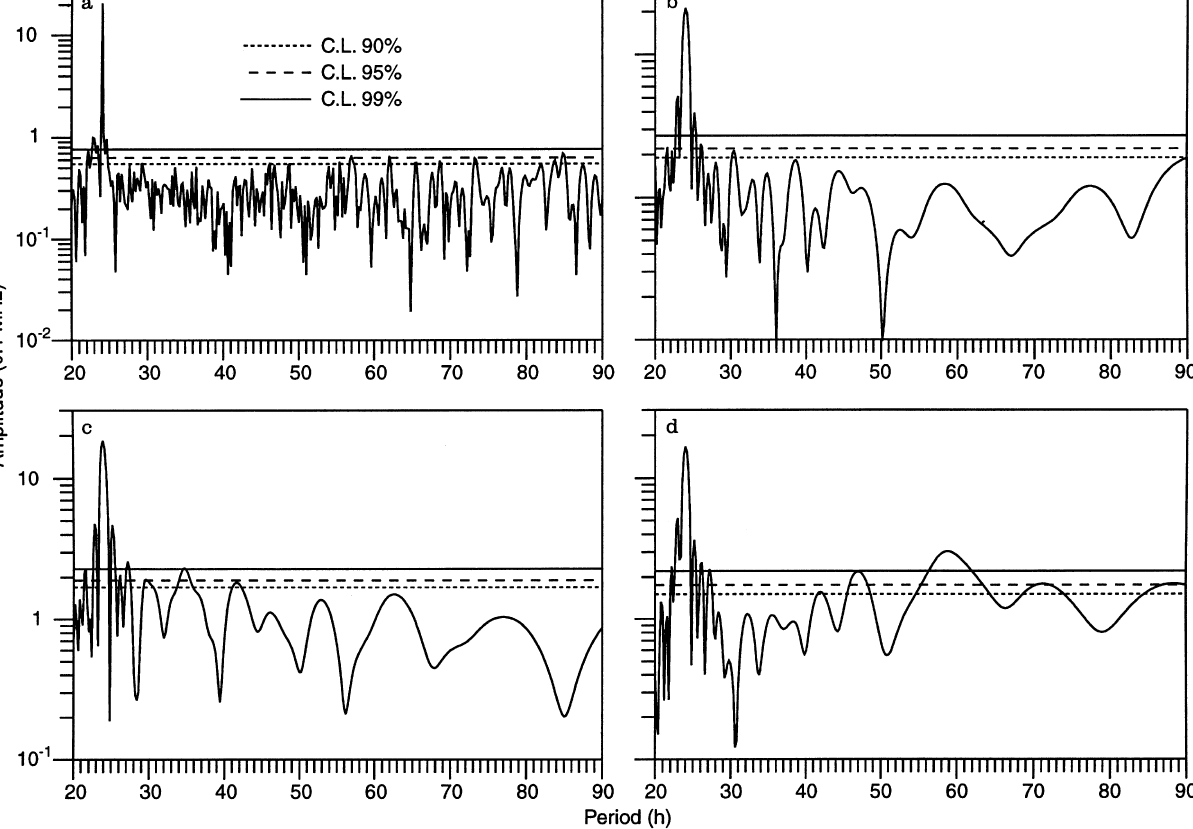
Fig. 1a–d. Amplitude spectra of the plasma frequency variations at 210 km altitude for: a the whole year 1995, b January, c April, and d July 1995. The horizontal lines are the confidence levels given in the